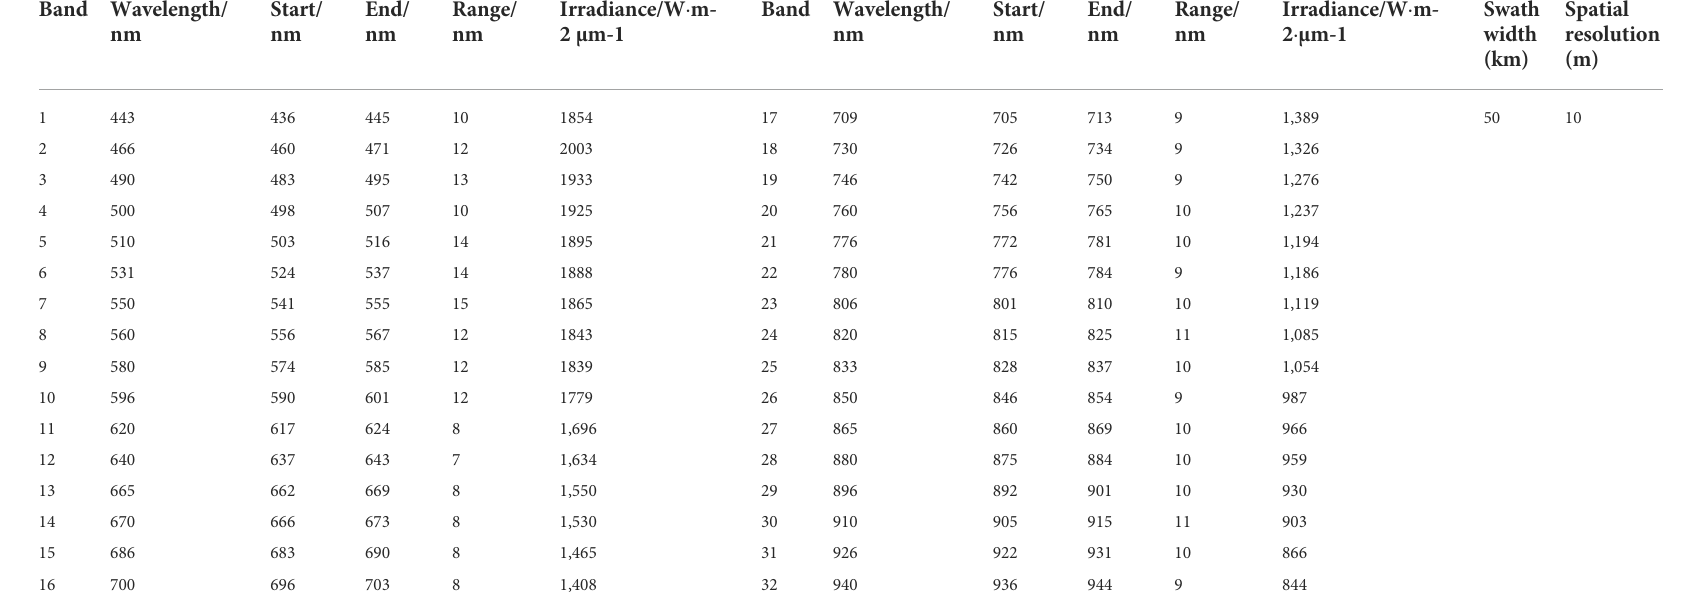
TABLE 1 OHS-3A CMOS1 hyperspectral sensor